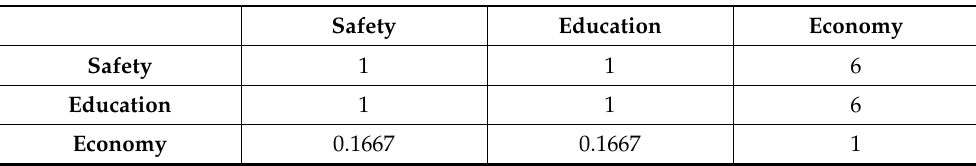
Table 3. Pairwise Comparison Matrix for the Three Criteria.